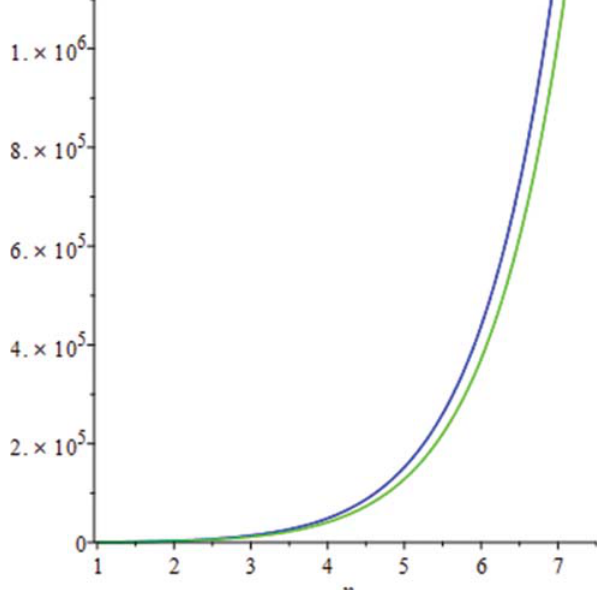
Figure 5: Comparison of first and second Zagreb-eccentricity index of siloxane nanostar dendrimer SD [r]. The colors blue and green represents the first and second Zagreb-eccentricity index of siloxane nanostar dendrimer SD [r], respectively. We can see that in the given domain the M 2* ( SD [r]) index of siloxane nanostar dendrimer SD [r] is more dominating.